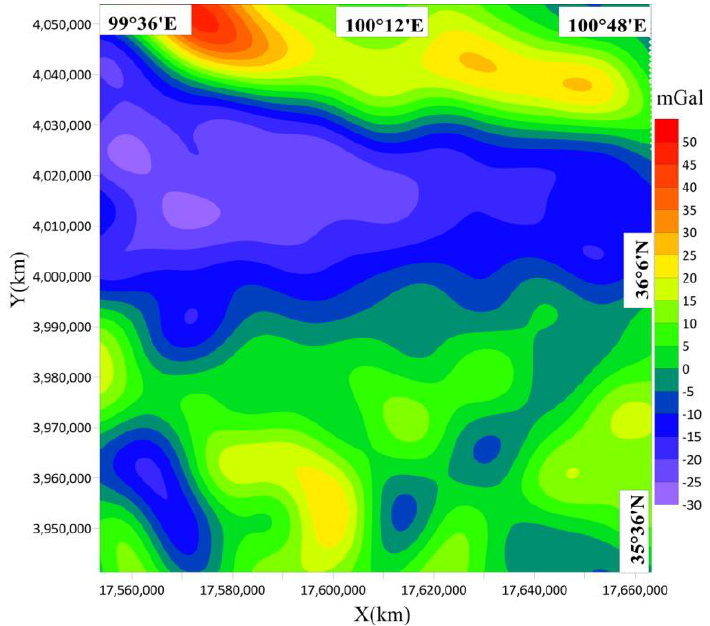
Figure 4. The residual Bouguer anomaly map.